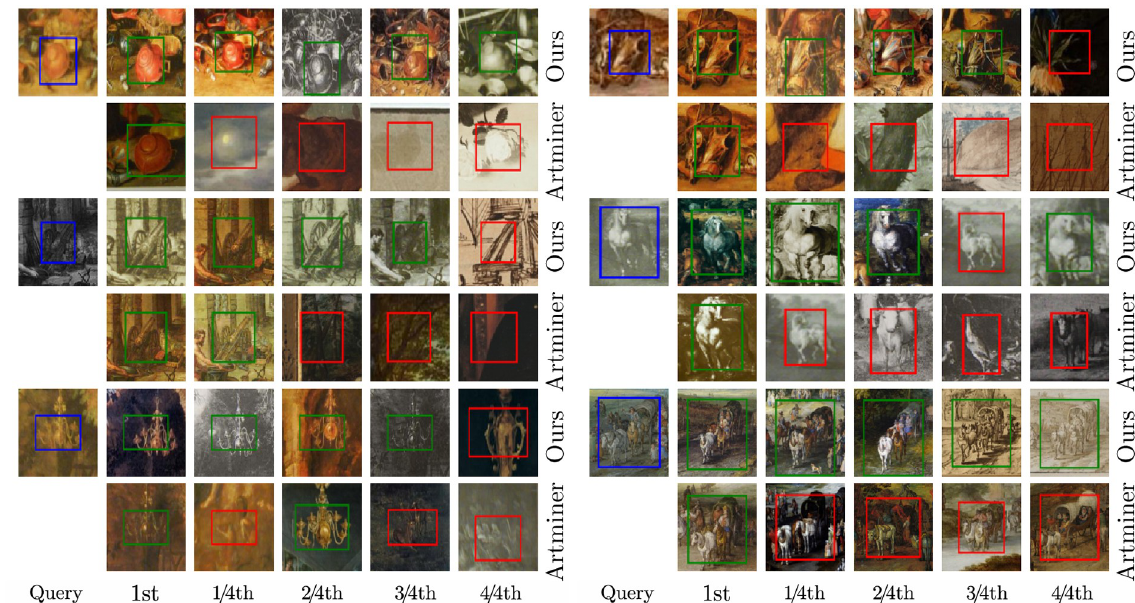
Fig 11. Qualitative comparison of our method with Artminer. Search examples of our approach (Ours) and Shen et al. [17] (Artminer) on the Brueghel dataset. Queries are shown in blue on the left and retrievals on the right. If the IoU is greater or smaller than 0.3, we draw green or red bounding boxes, respectively. For a better overview, we draw only the first and four additional retrievals with equidistant ranks. We set the distance between ranks to the number of ground truth matches of this query divided by four. Due to copyright issues, we replaced several images. We made sure that replacements are as similar as possible to the originals. The original figure is also available on our project website. The image material is shared by Wikimedia Commons [5] as public domain.